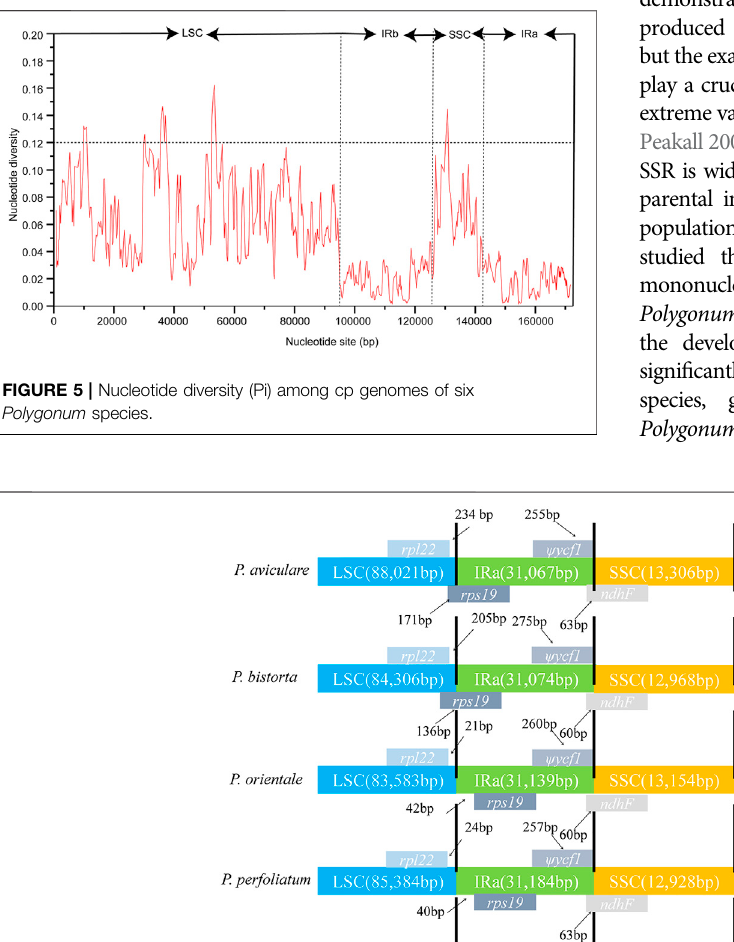
Frontiers in Genetics |